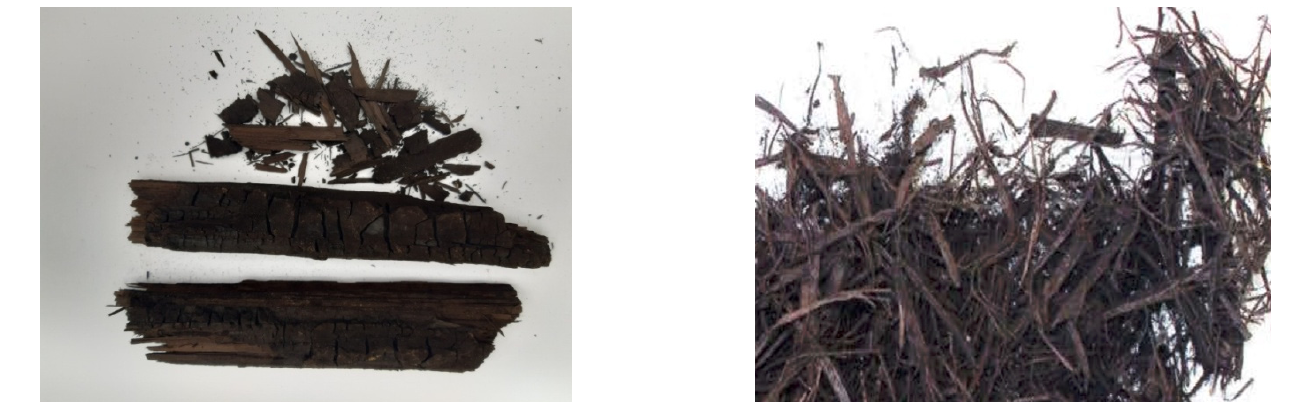
Figure 2. Forms of material (xylit) used: left : scraps; right : angel hair.